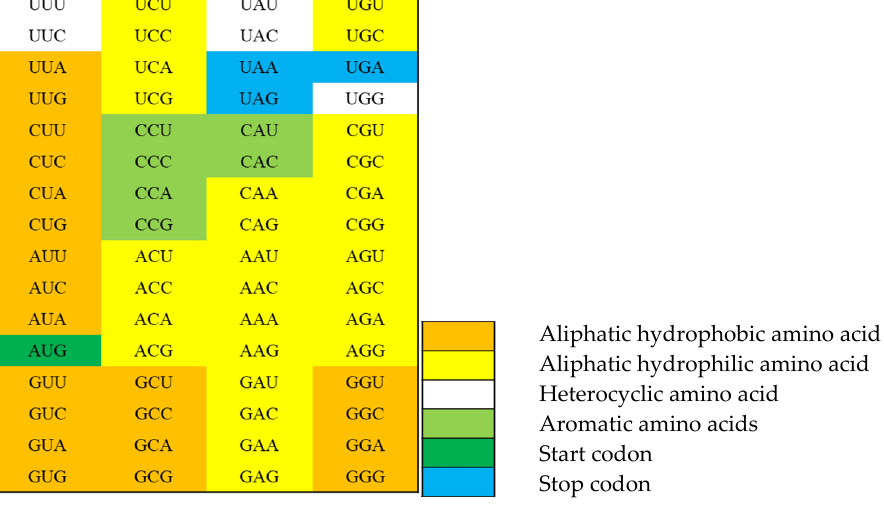
Figure 4. Amino acid codon table in RNA.